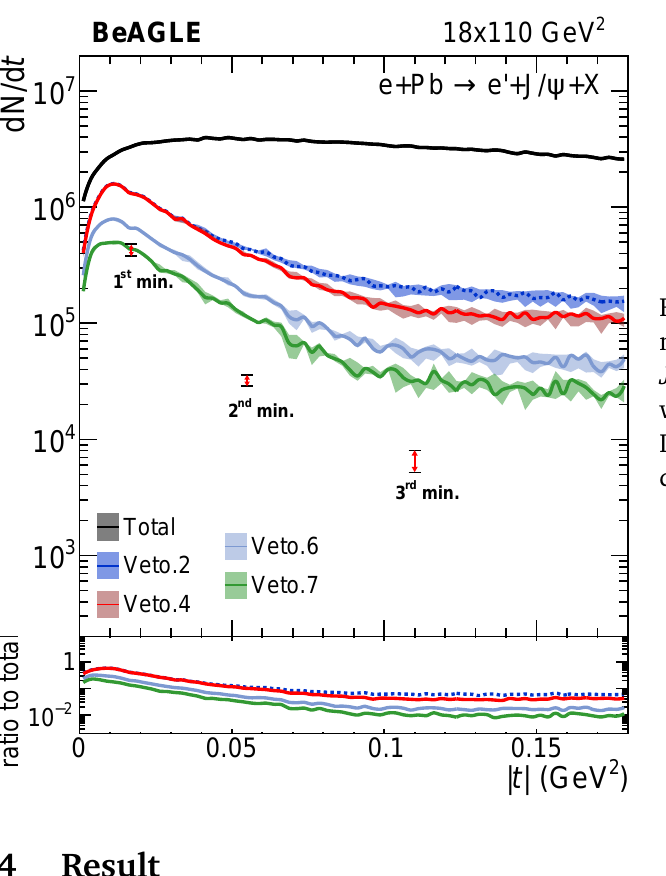
Figure 1: Distribution of the mo- mentum transfer | t | for incoherent J /ψ production in eP b collisions with 18 GeV on 110 GeV at the EIC. Different lines indicate results after different vetoing